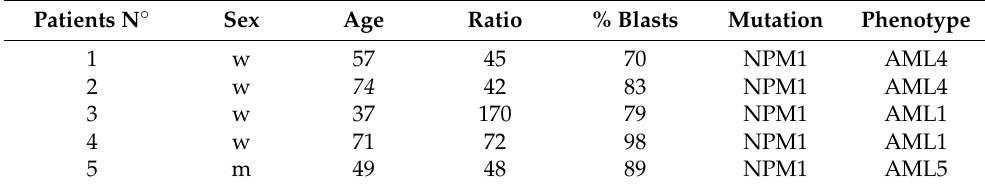
Table 1. Biological characteristics of AML